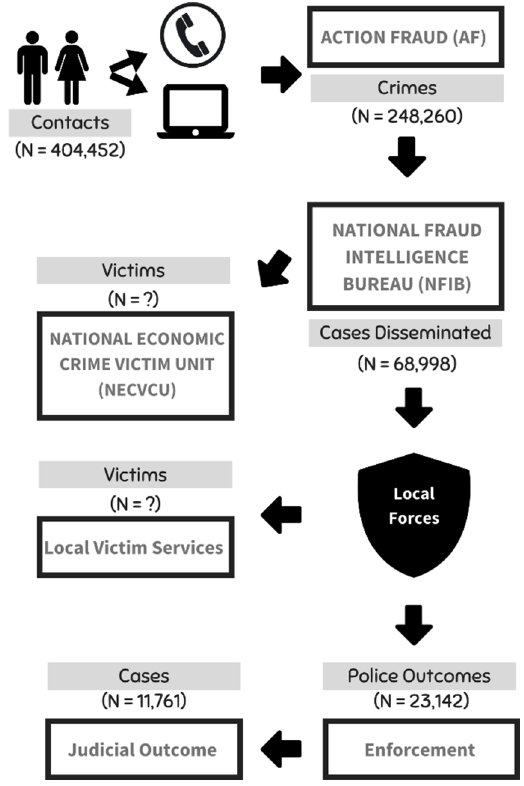
Table 3: Demographic, vulnerability and impact variables collected by AF and shared with local forces Variable